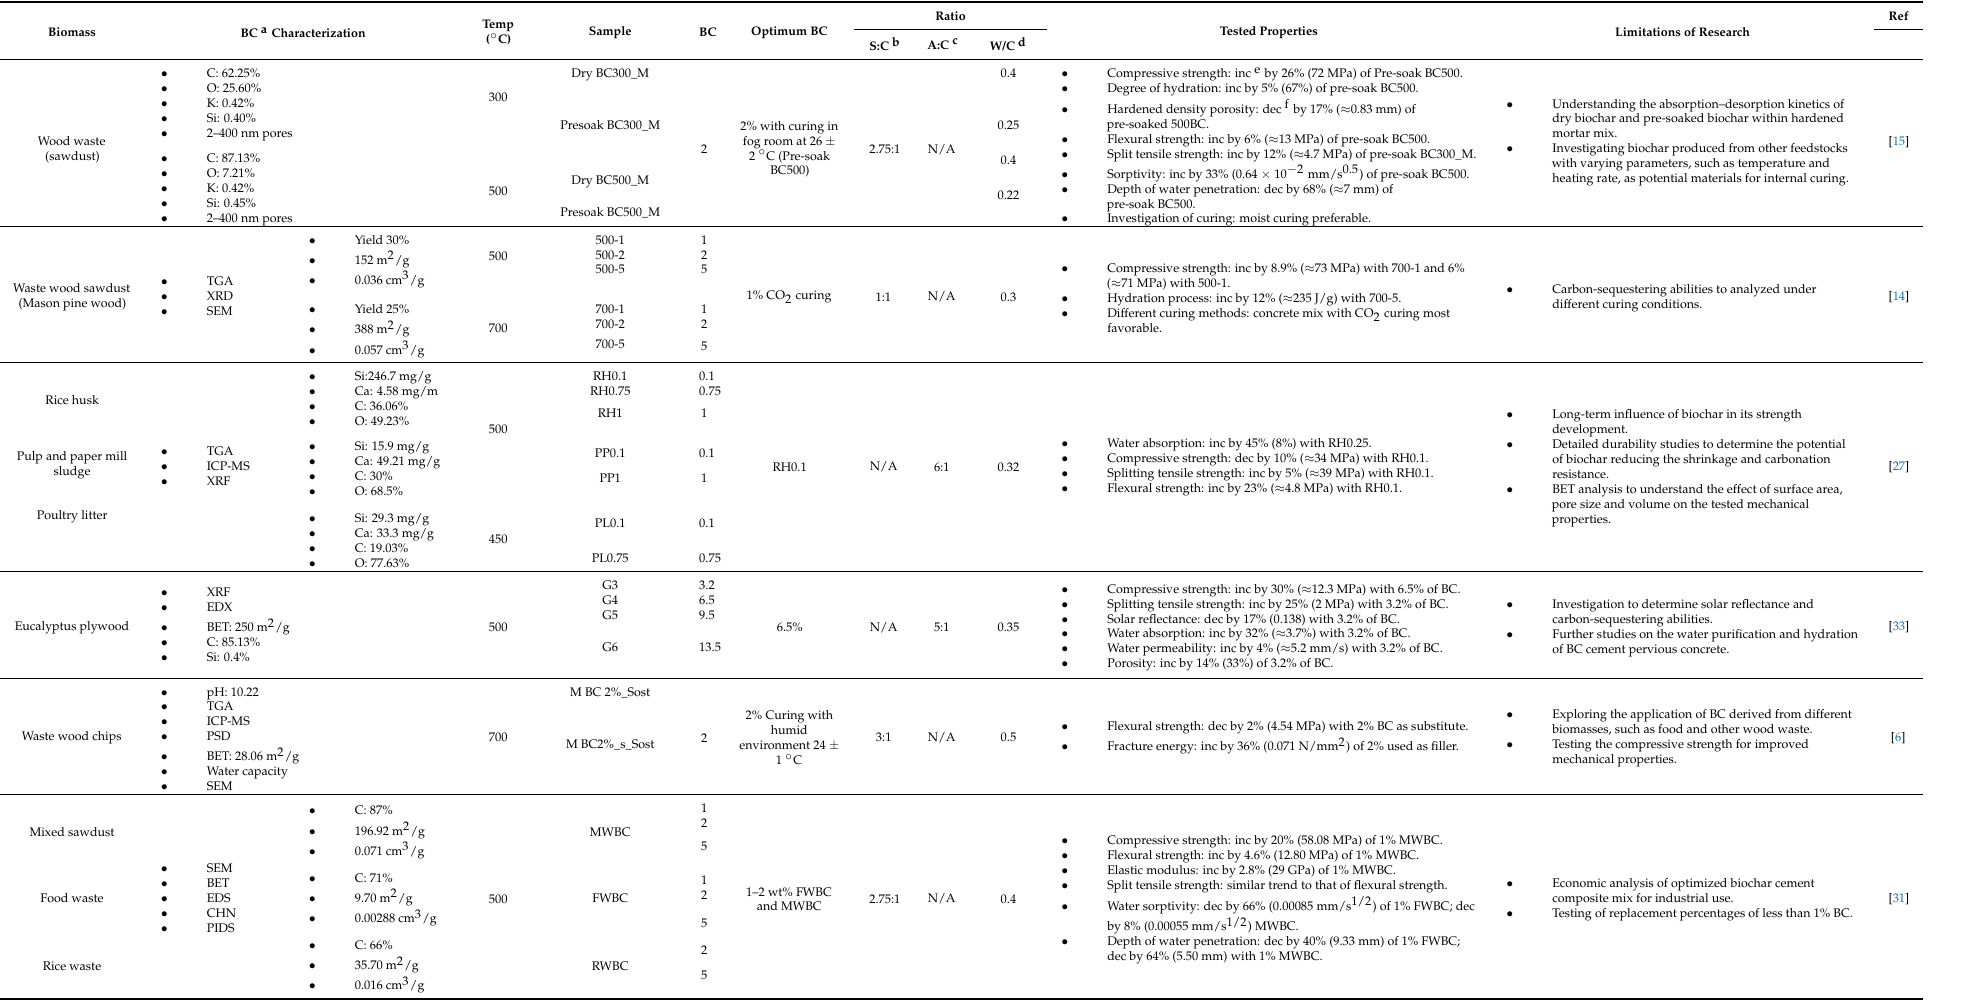
Table 3. Summary of various studies on biochar production and characterization, as well as optimum biochar content as cementitious materials and respective composite properties and